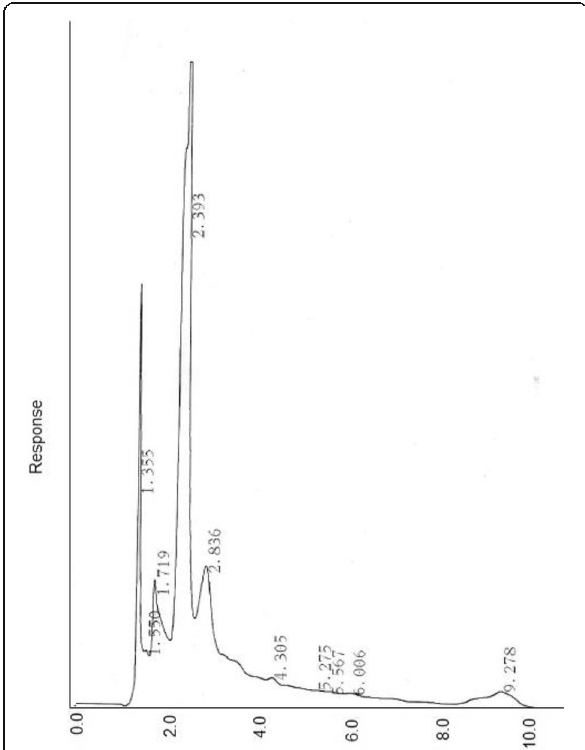
Fig. 2 Mean of percentage cell viability (± SD) of HEp-2 cells determined by MTT assay ( a ) and EC 50 values (± SD) after 12, 24 and 72 hour ( b ) exposure of S parvifolia Thw. leaves ( n = 3)